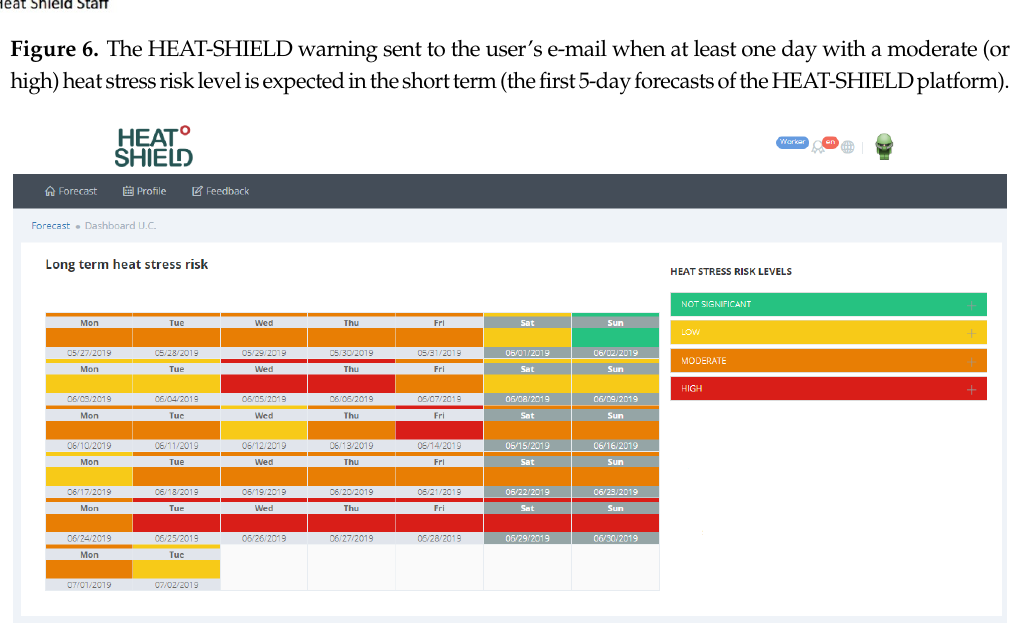
Figure 7. Worker ’ s heat stress risk in the long term (from the 6th to the 46th day forecasted) available in the own profile of the personalized heat stress warning.